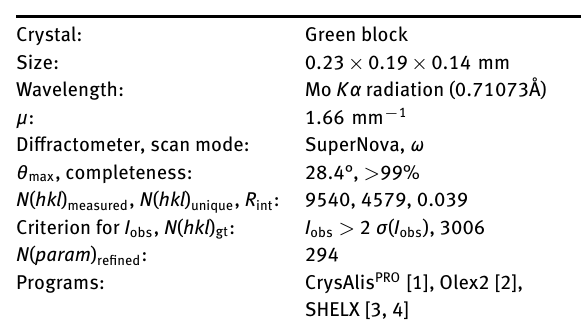
Table 1: Data collection and